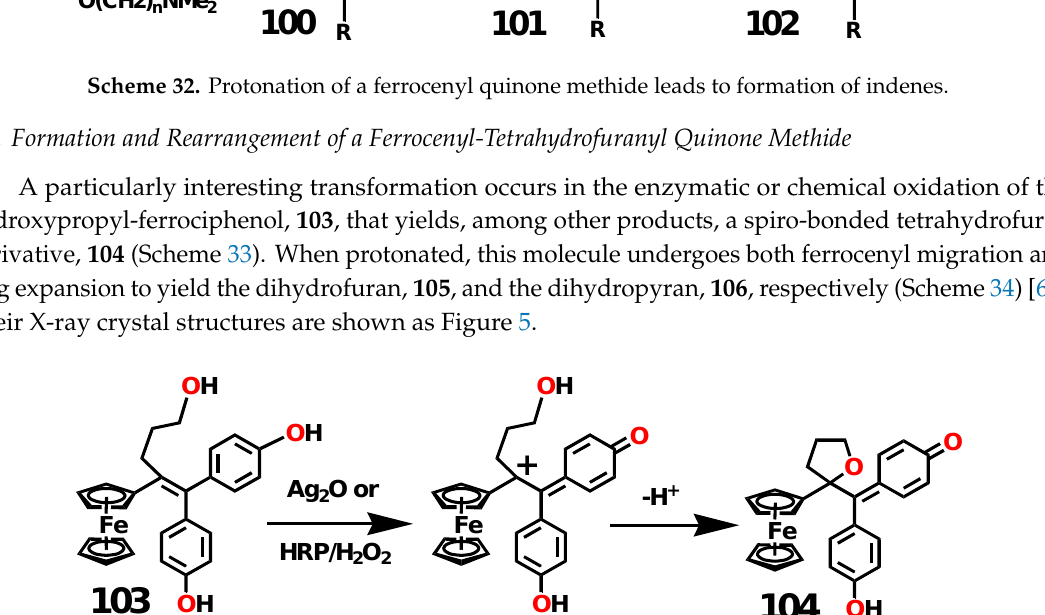
106 Scheme 34. Ferrocenyl migration and ring expansion upon protonation of the tetrahydrofuranyl- quinone methide, 104 . Figure 5. Molecular structures of (left) dihydrofuran, 105 , and (right) dihydropyran, 106 . 7.4. Pinacol-to-Pinacolone Rearrangement of Ansa-Ferrociphenols In yet another example in the bioorganometallic arena, the synthesis of an ansa -ferrociphenol from [3]ferrocenophanone, 107 , by McMurry coupling yields not only the desired alkene, 108 , but also the corresponding pinacolone, 109 , (Scheme 35) both of whose X-ray crystal structures are shown as Figure 6.